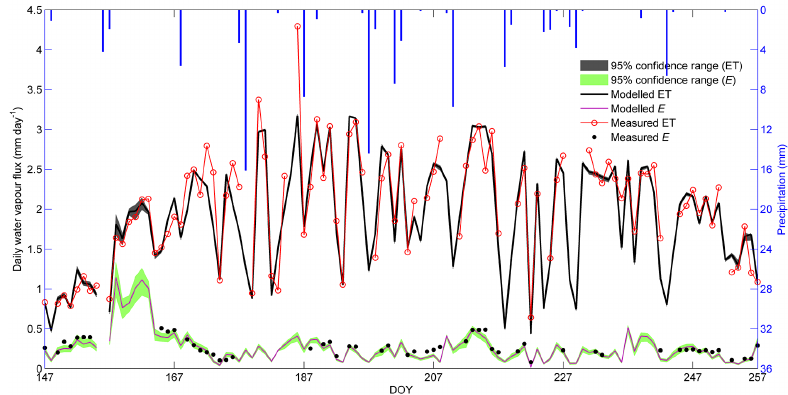
Figure 8. Seasonal variation in daily evapotranspiration (ET; mmday − 1 ) and soil evaporation ( E ; mm day − 1 ) measured by the EC system and modeled by the S–W model during the study period in the Daman Oasis. A gap in the time series is caused either by the absence of flux measurements or missing ancillary data.